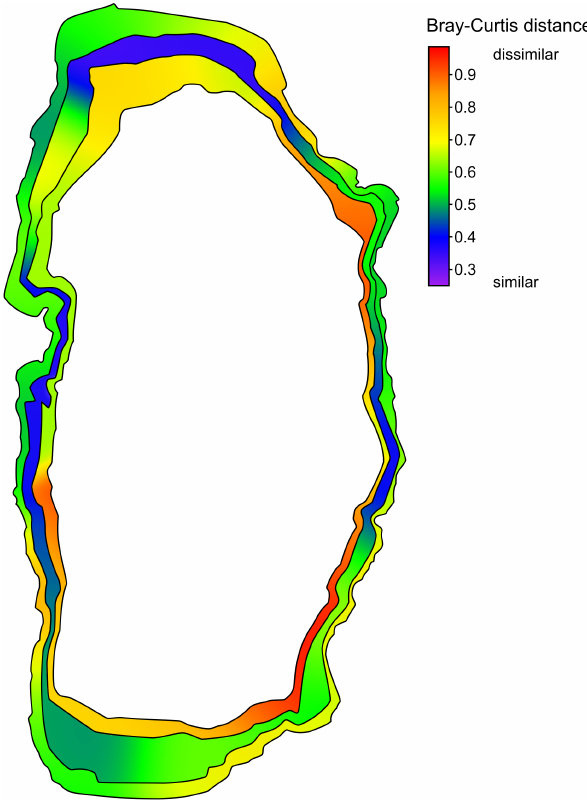
Fig. 6. Similarity map of the thanatocoenosis of core Co1200 and recent gastropod communities in ancient Lake Ohrid. Three habitat zones are shown: Surface Layer (0–5m), Intermediate Layer (5– 25m), and Deep Layer (25–50m). Note that the extents of the zones are not to scale with Albrecht and Wilke